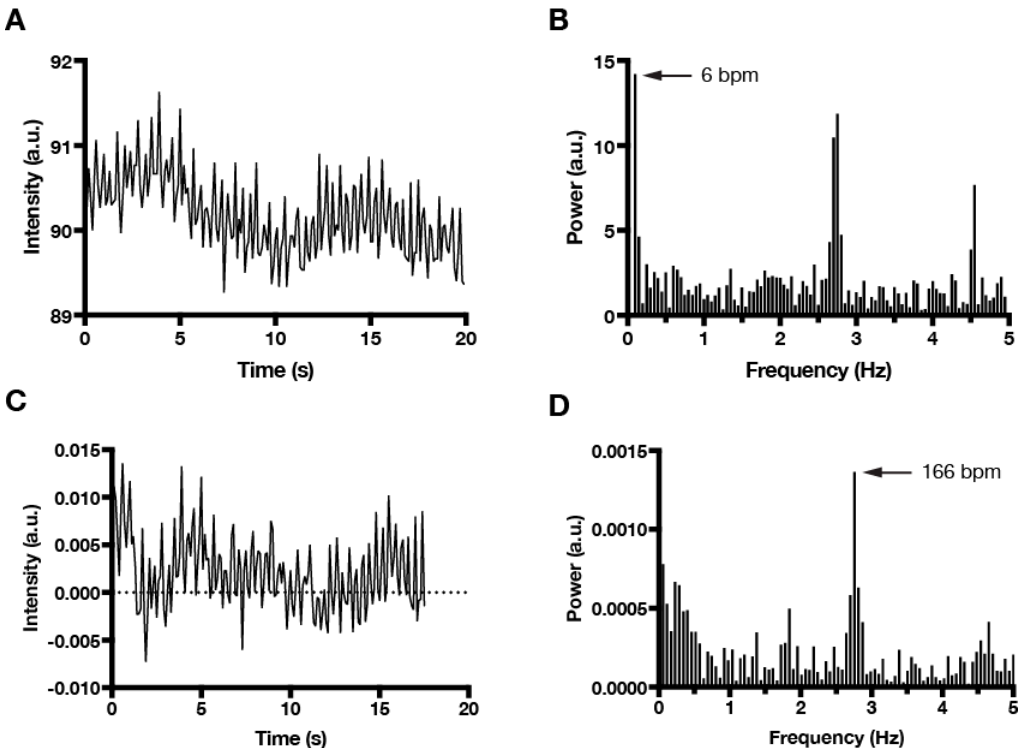
Figure 2. Normalization of time series data and FFT (fast Fourier transform) power spectrum analysis to beating frequency. ( A ) Raw time series data showing high frequency changes in mean intensity combined with slow, sinusoidal changes due to secondary motion imaging artifact. ( B ) FFT plot of the raw time series data attributes dominant beating frequency (6 bpm) to motion caused by imaging artifact. ( C ) Normalization of time series data eliminates changes due to secondary imaging artifacts. ( D ) FFT plot of normalized time series data correctly identifies fast beating (166 bpm) as the dominant frequency.